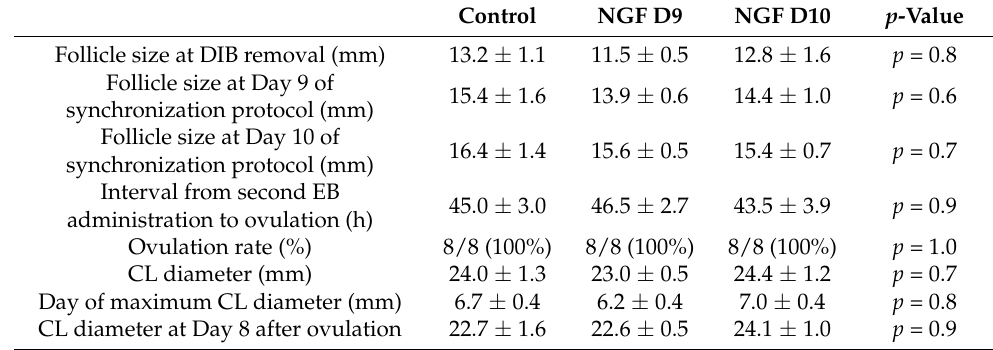
Table 2. Follicular and luteal parameters, interval to ovulation (h), and ovulation rate (%) following systemic NGF administration during the preovulatory stage in dairy heifers (n = 8 per group, mean ±